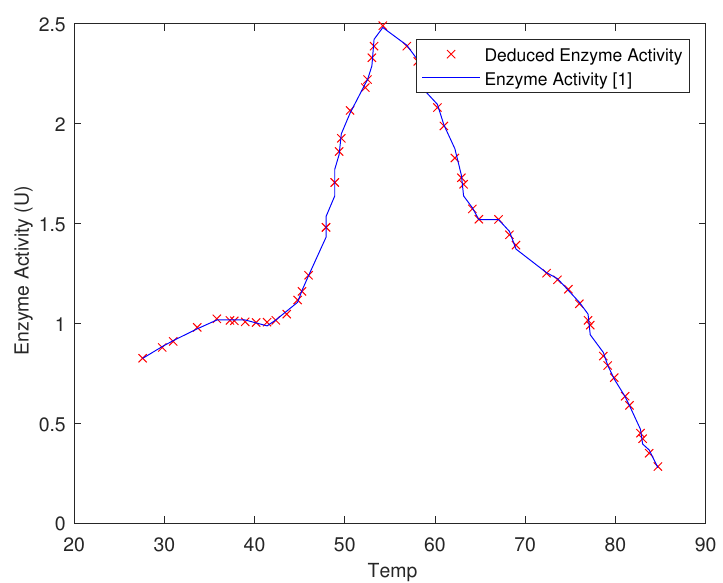
Figure 9. Performance of SISO temp–enzyme activity FIS model. (U = µ mol/min), temp = ◦ C). The ANFIS SISO model for the pH–enzyme activity is trained to capture the nonlinear relationship between reaction pH and enzyme activity, as shown in Figure 10. The training goal was reached with a mean error of 2.577 × 10 − 7 .